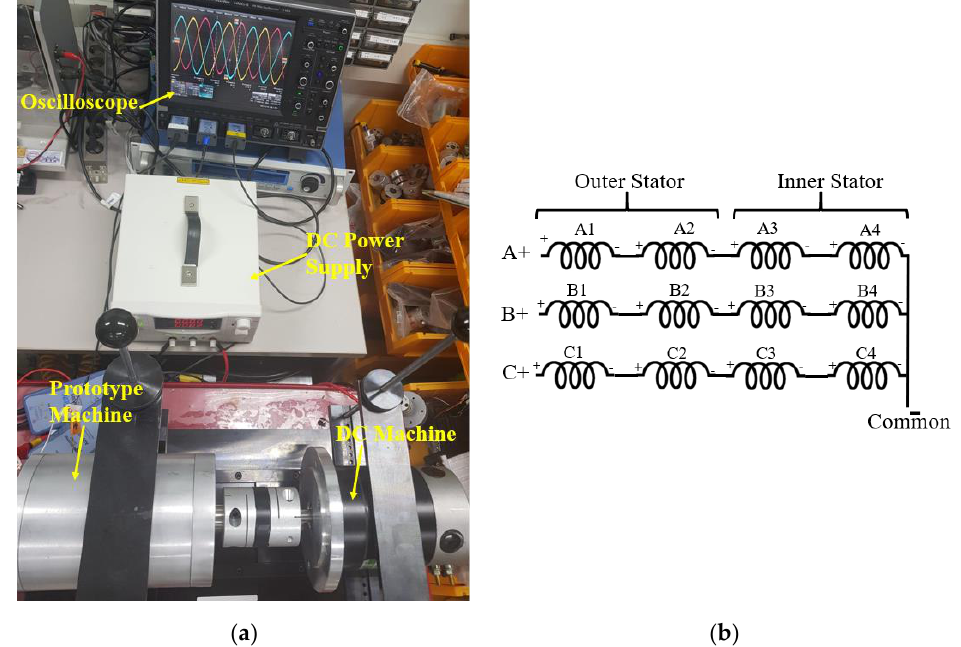
Figure 16. Experimental setup ( a ) Testbed for the yokeless rotor DARF PMVM experiment; ( b ) winding connections.